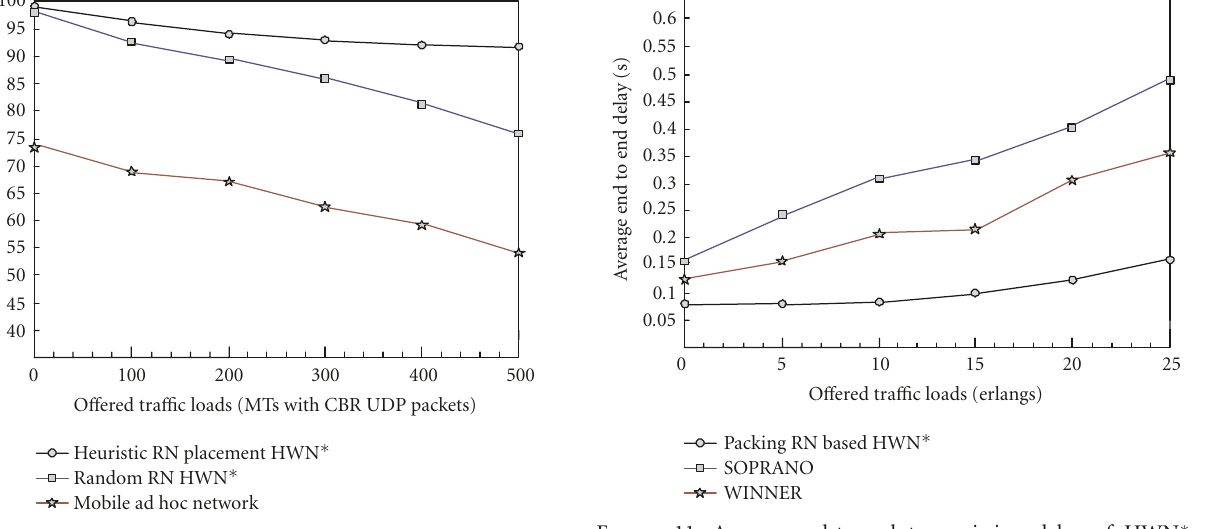
Figure 10: Heuristic RN HWN ∗ , random RN HWN ∗ , and MANET throughput versus o ff ered load.